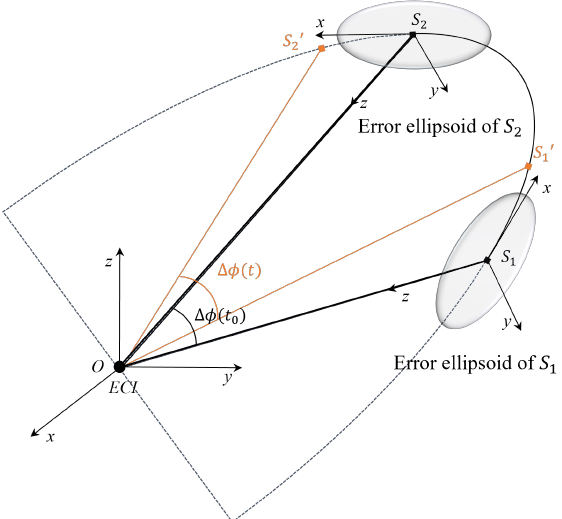
Figure 1. Evolution of Phase Deviation of two co-planar